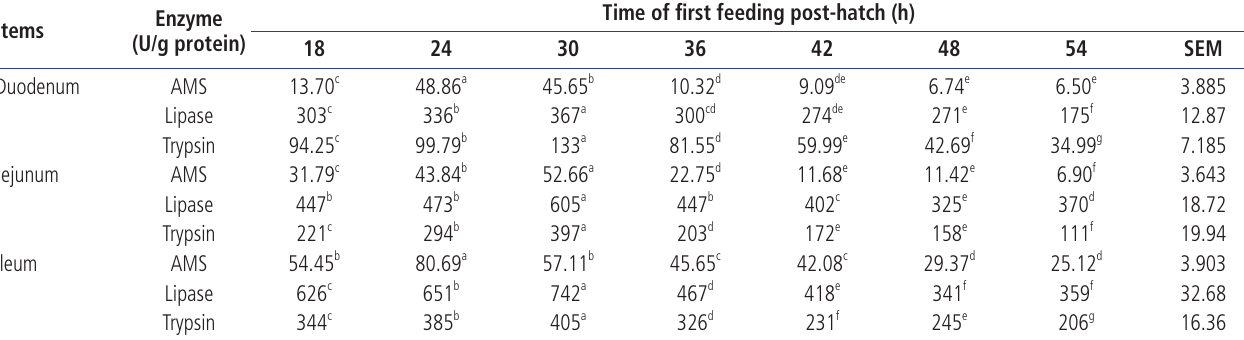
Time of first feeding post-hatch